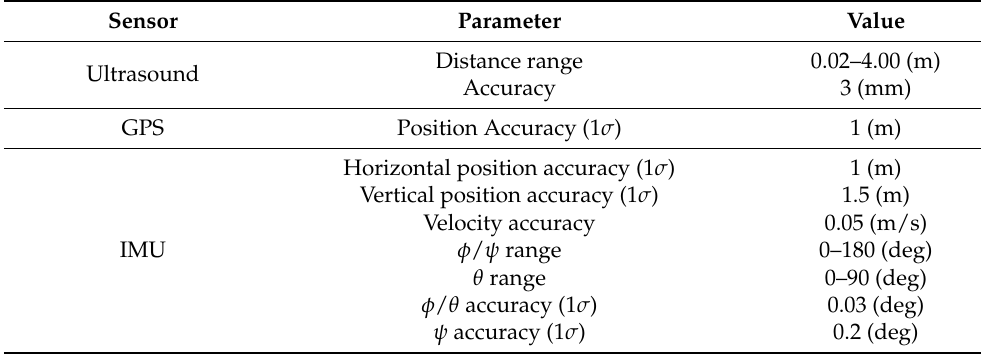
Table 2. Features of the sensors equipped onboard the